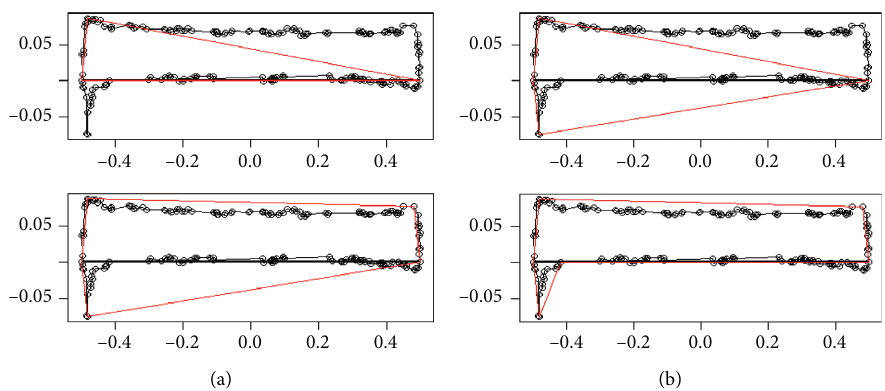
Figure 6: Region 2 of Rothko’s “Violet, Black, Orange, Yellow on White and Red” (1949) work. 3, 4, 5, and 6 points simplification in red.